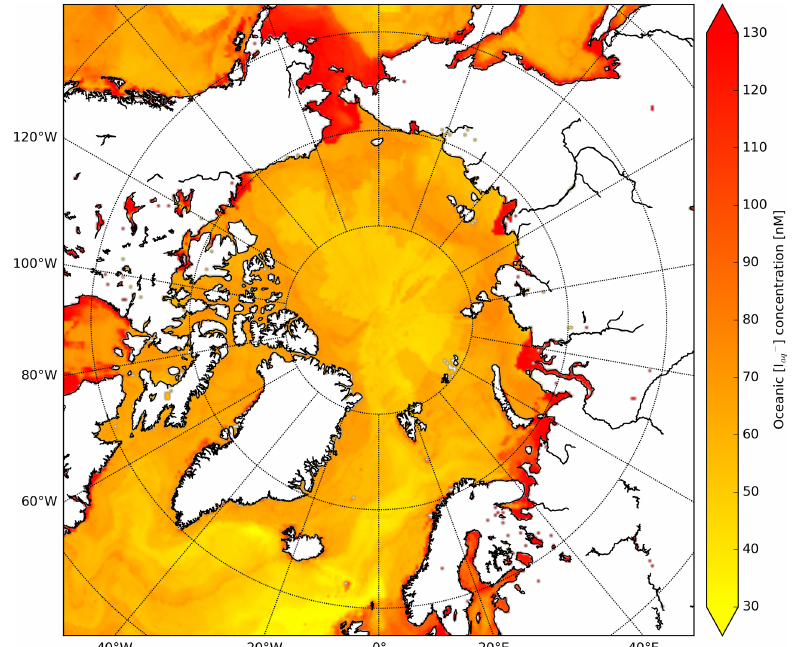
Figure C1. Spatial distribution of Sherwen et al. (2019) oceanic iodide concentrations (nM) at the start of the simulation.